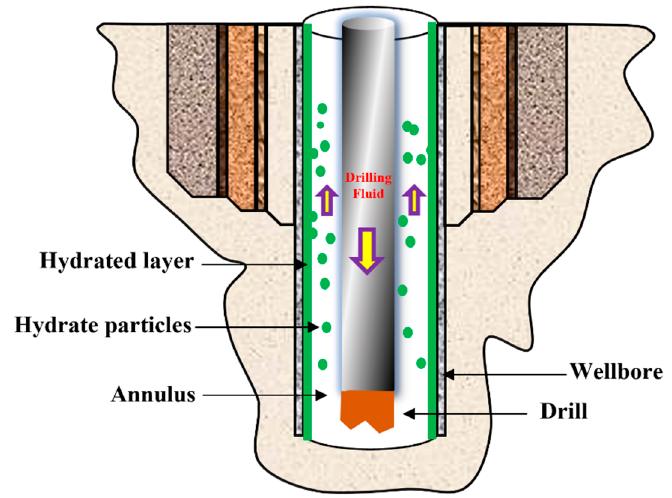
Figure 4. Formation and deposition of hydrates in the wellbore.